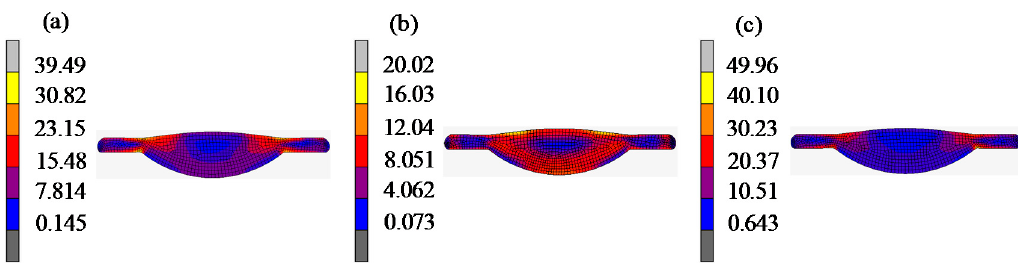
Figure 15. Form errors of simulated surface profiles.